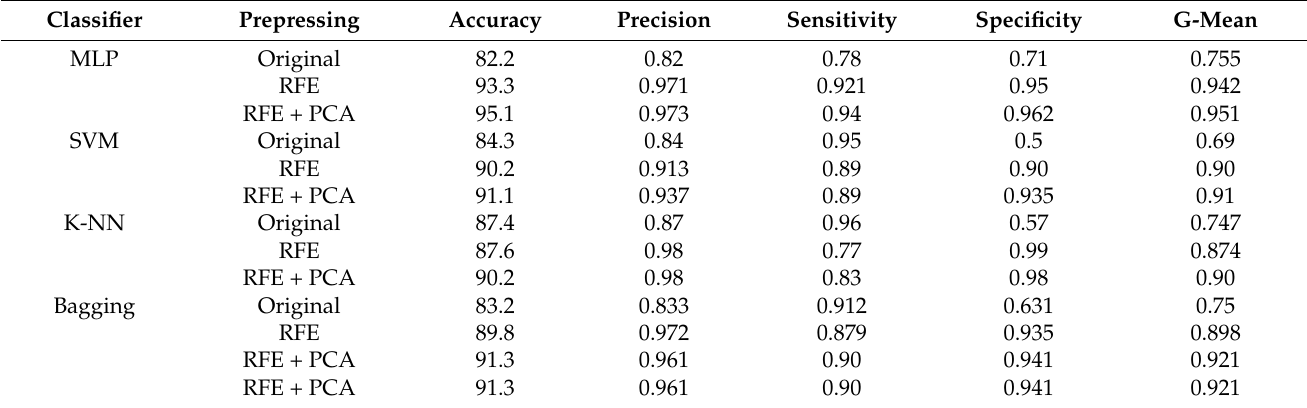
Table 3. Classifier evaluation results with the original and preprocessed versions of the PD dataset.